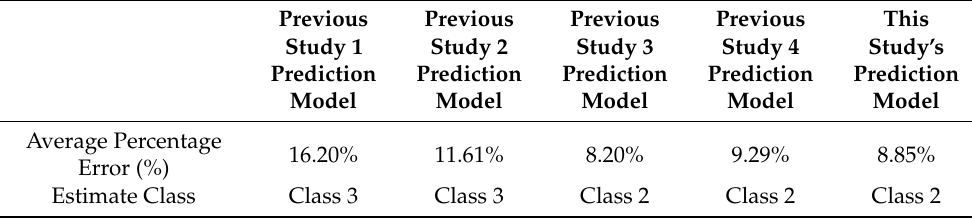
Table 9. Performance comparison with the prediction models of previous studies (Table